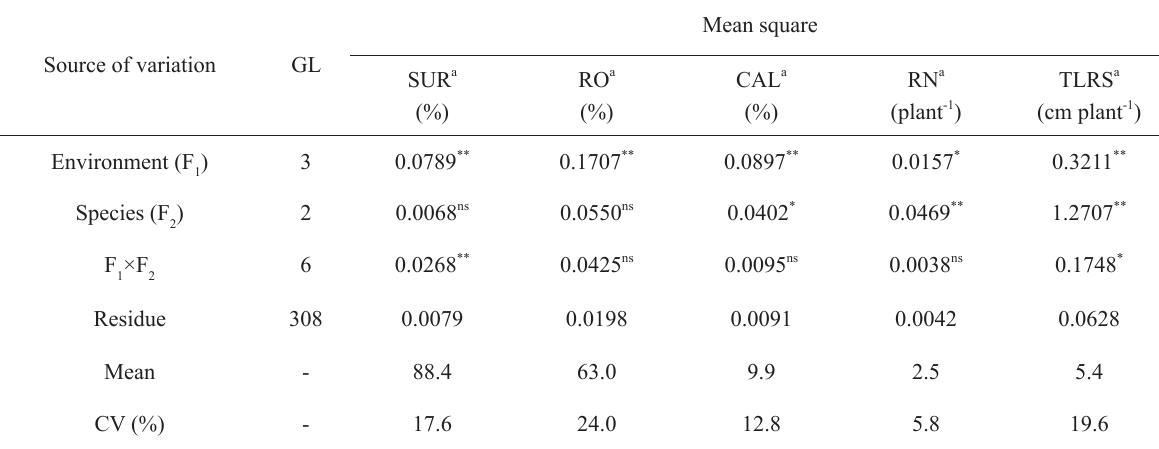
Summary of the analysis of variance (ANOVA) for the percentage of survival (SUR), percentage of adventitious rooting (RO), percentage of callogenesis (CAL), number of roots per plant (RN) and total length of the roots per plant (TLRS) of Corymbia citriodora , Eucalyptus urophylla and Eucalyptus benthamii microcuttings after 22 days in the rooting environment.